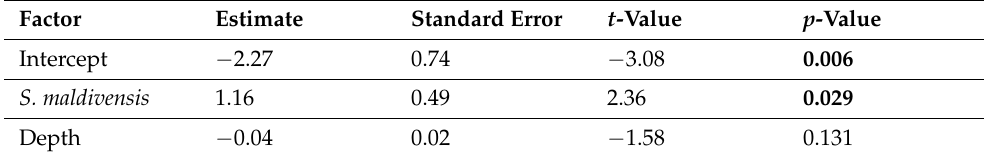
Table 1. Results of the quasi-Poisson GLM test for differences between species and depths. The